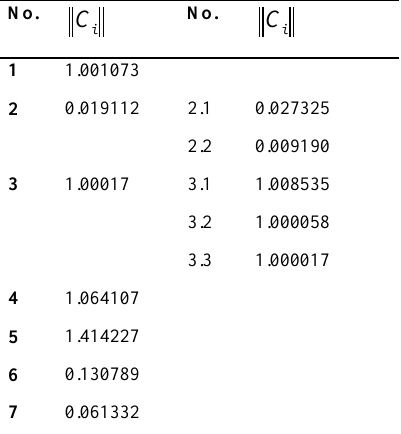
Figure 2. First graph, from above, illustrates number of clustering solutions having insurable groups among 1000 solutions for different number of clusters. Second one shows minimum value of intra-dispersion index over 1000 solutions, and third one denotes dispersion of centers.